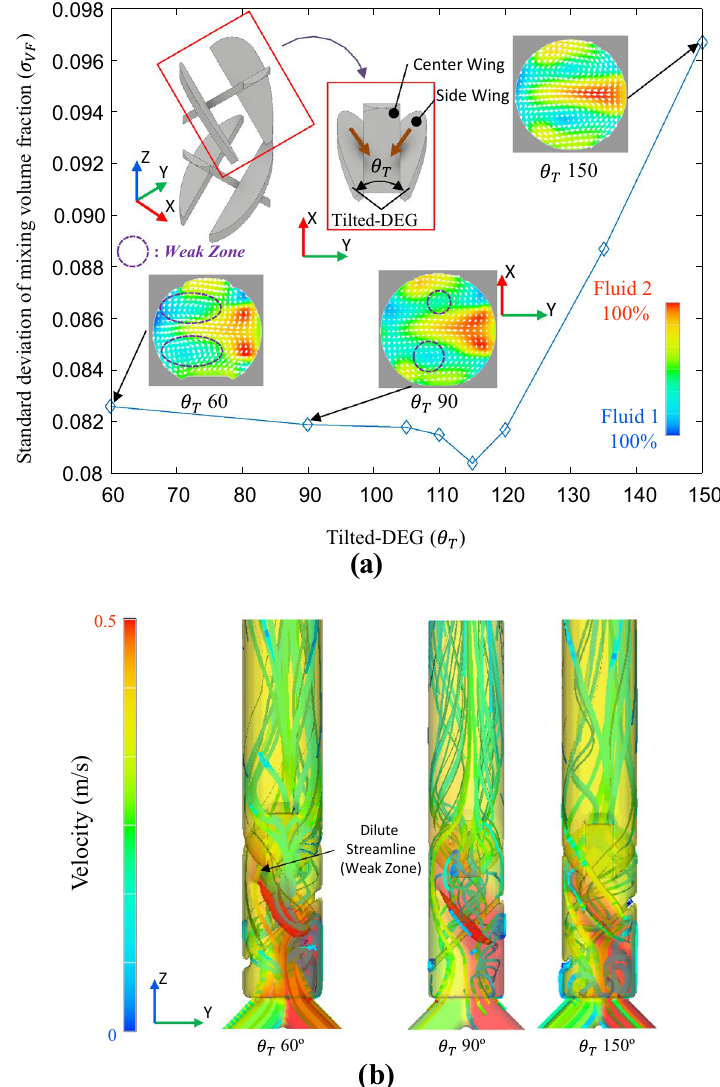
Figure 5. ( a ) Mixing performance according to θ T ; As θ T is away from 115°, a small area of high-velocity distribution occurs, and ( b ) streamline according to variation of θ T ; as θ T decrease, weak-zone is increased (at θ T =